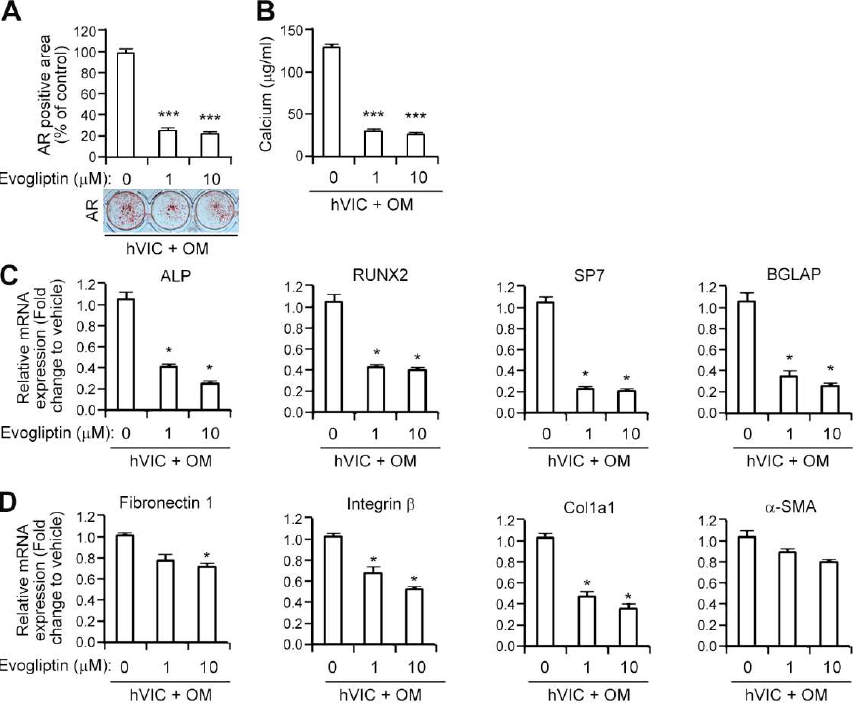
Figure 2. Evogliptin attenuates the osteogenic transition of aortic valvular interstitial cells by reducing the transcript expression of osteogenesis-associated genes in vitro. ( A ) After 3 weeks of osteogenic stimulation of human valvular interstitial cells (hVICs) in the presence or absence of evogliptin (1 or 10 µ M), alizarin red (AR) staining was conducted (lower). The bar graph presents the relative alizarin red-positive area measured in each culture dish (upper). ( B ) The calcium concentration in the cells shown in ( A ) was measured. ( C ) Quantitative reverse transcription polymerase chain reaction (qPCR) analysis was performed to evaluate mRNA expression levels of ALP (alkaline phosphatase), RUNX2 (Runt-related transcription factor 2), Sp7 (Sp7 Transcription Factor), and BGLAP (bone gamma- carboxyglutamic acid-containing protein) in hVICs in the presence of the indicated concentrations of evogliptin. ( D ) The transcript levels of fibrosis-related genes including fibronectin 1, integrin β , Col1a1, and α -smooth muscle actin ( α -SMA) were determined using qPCR in hVICs in the presence of various concentrations of evogliptin. * p < 0.05, *** p < 0.0005 versus vehicle control. Data